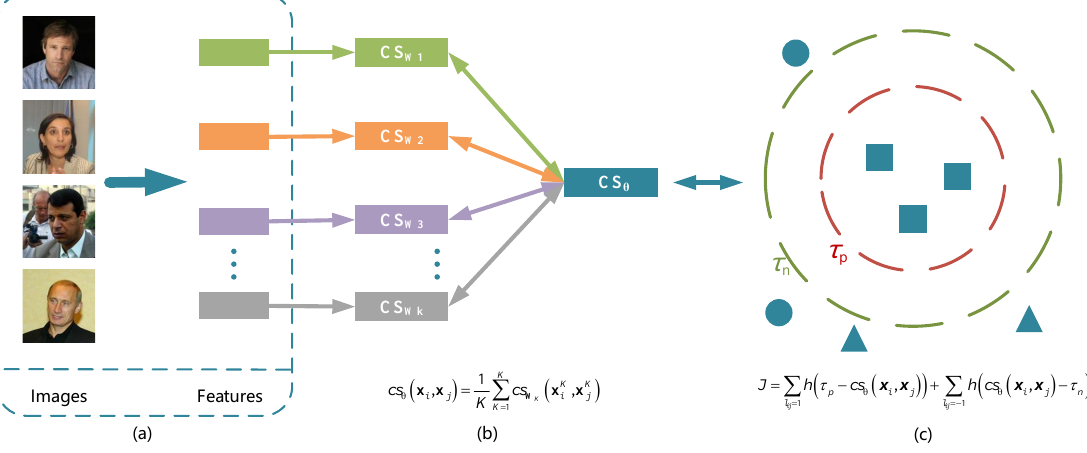
Figure 1. Illustration of the basic ideas of the proposed MVCSL method. ( a ) Preprocessing, ( b ) cosine metric, ( c ) MVCSL. Given multi-view feature representations of each sample, MVCSL under the large margin framework learns the optimal combination of the cosine similarities of multi-view data, which constrains the joint cosine similarity of positive samples to be greater than a large value t p and that of negative samples to be less than a small value t n